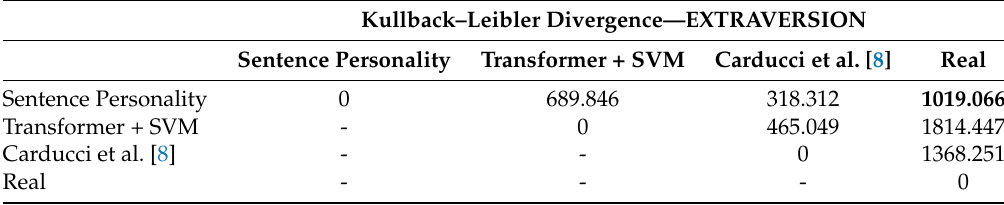
Table 6. Kullback–Leibler divergence computed among probability distributions on